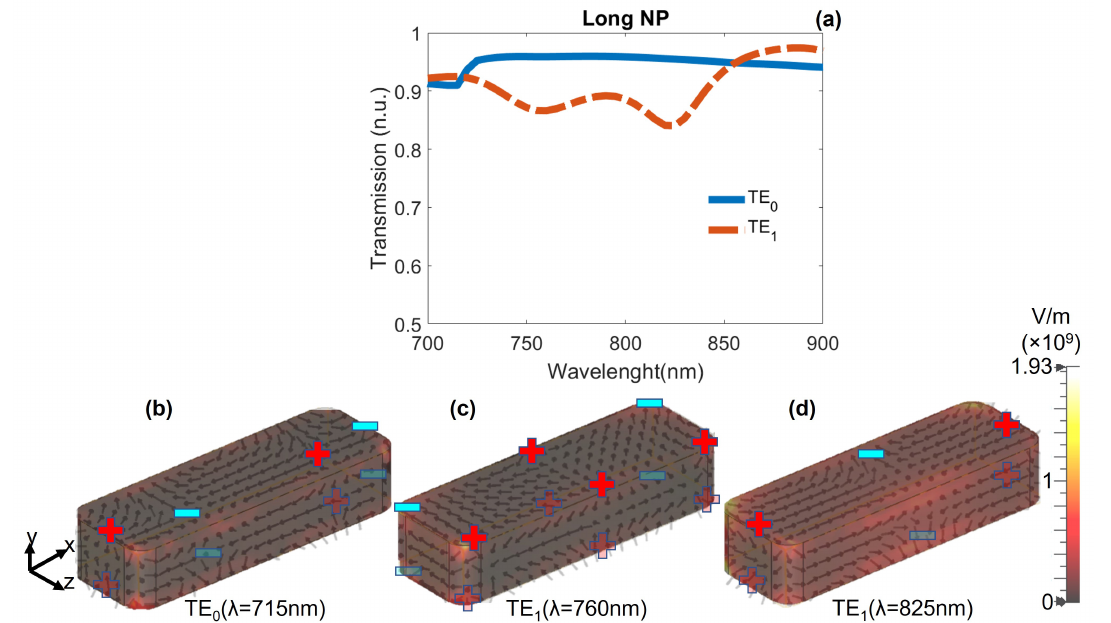
Figure 4. ( a ) Transmission spectra for the TE 0 and TE 1 modes exciting a long NP ( w x 2 = 150 nm) placed at the center of the core. ( b – d ) Schematics of the electric field lines on the NP at the minimum values for the TE 0 and TE 1